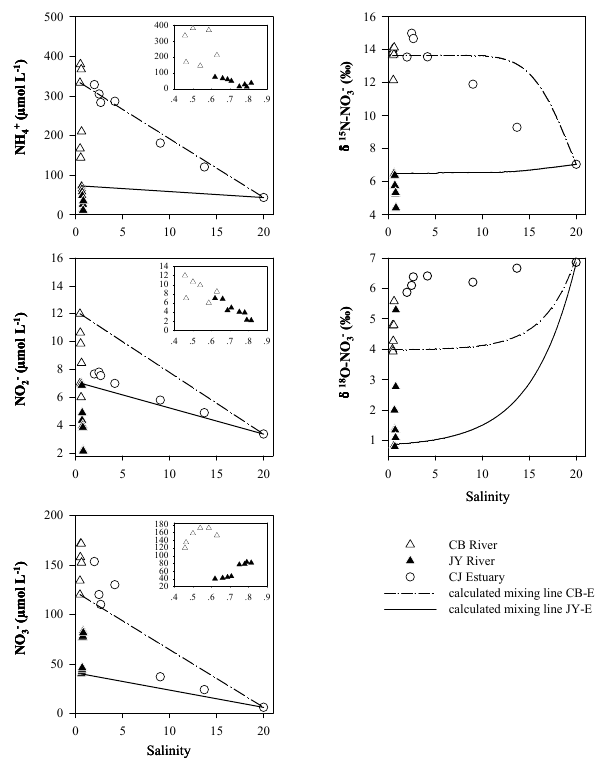
) concentrations and isotopic Figure 4. DIN (NH + , NO − , NO − 4 2 3 composition of NO − versus salinity in the CB River, the JY River 3 and the CJ Estuary. CB-E represented the calculated mixing line between the CB River and the CJ Estuary; JY-E represented the cal- culated mixing line between the JY River and the CJ